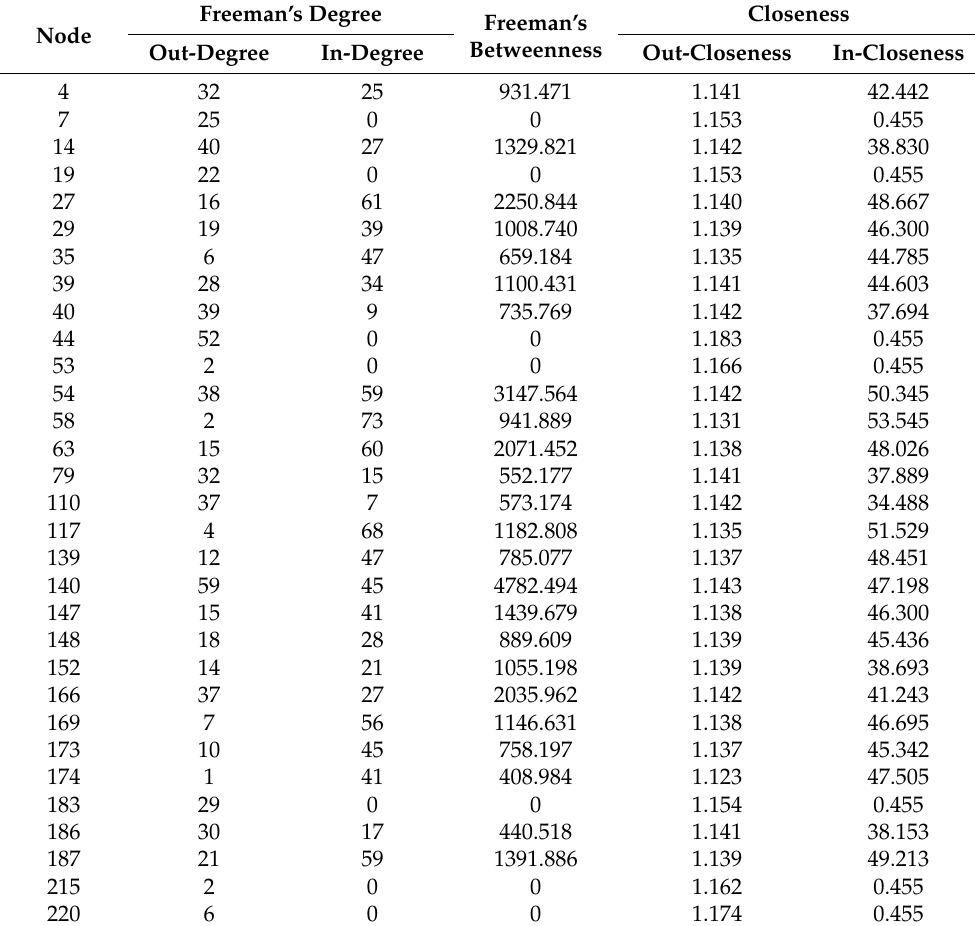
Table 2. Centrality of the opinion leader information dissemination